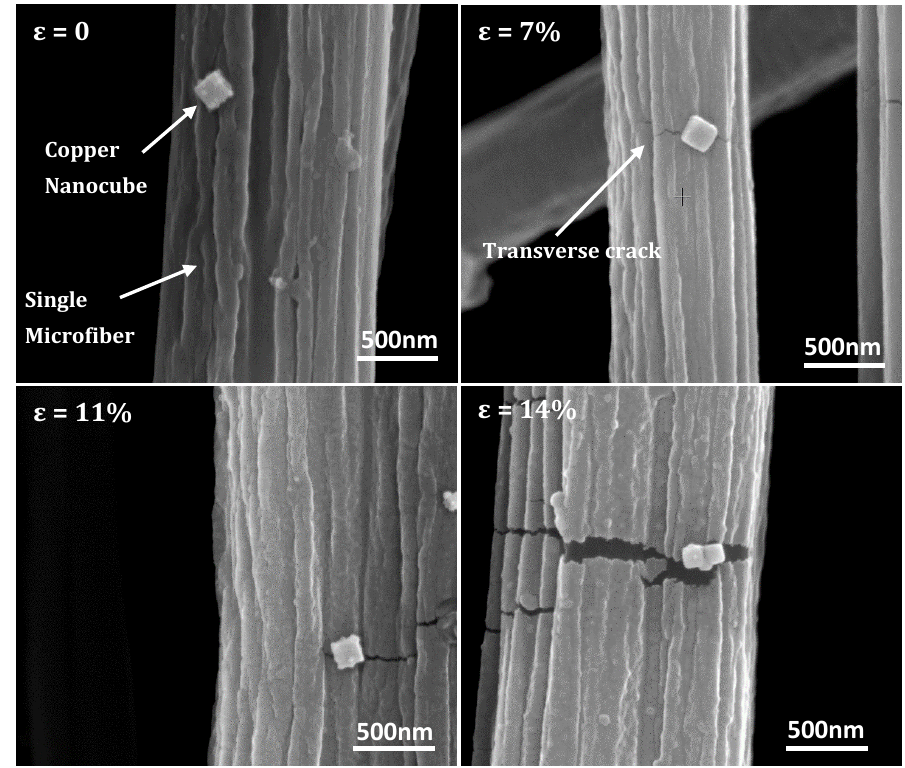
Figure 6. Representative microstructures for: ( a ) PAN microfiber at zero strain; ( b ) ε = 7%; ( c ) adhered nanocubes in path of advancing transverse crack at ε = 11%; ( d ) adhered nanocubes at ε = 14%.